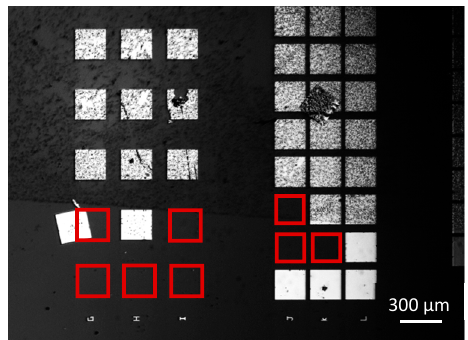
Figure 2. SEM image of functional chips consisting of Si NN–FETs evidencing metal contact delamination due to the reduction reaction step related to the APTES-based functionalization protocol.